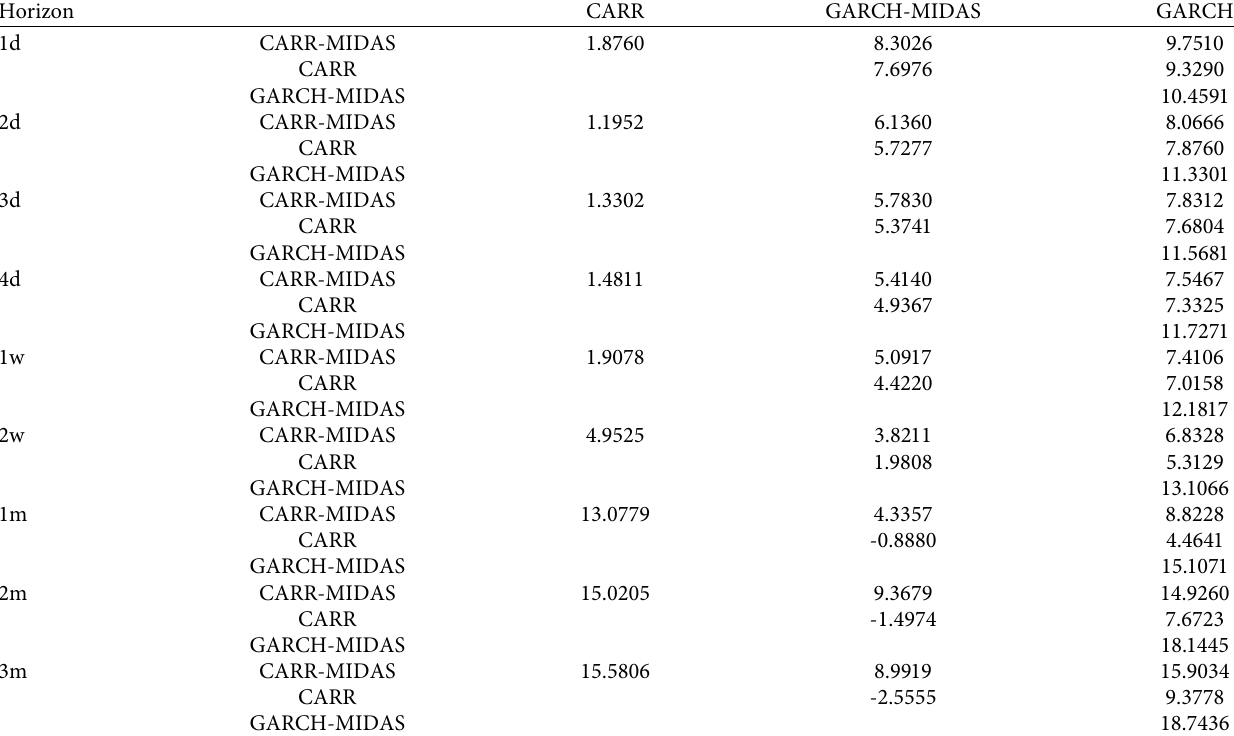
Table 4: Diebold-Mariano statistics.